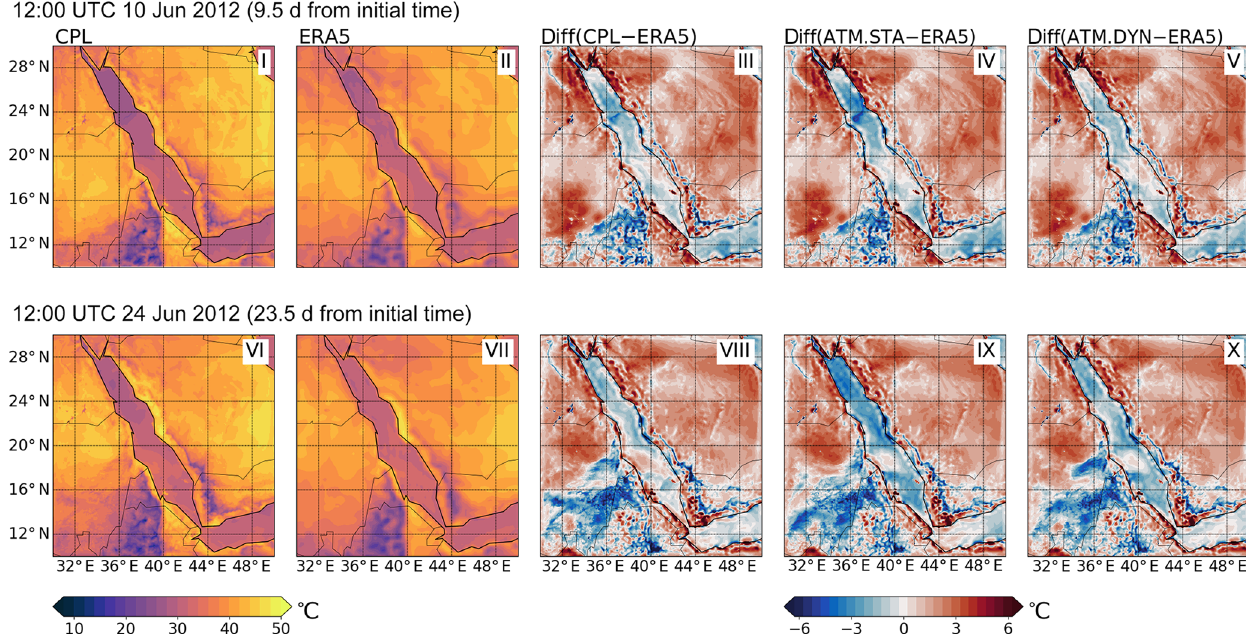
Figure 5. The T 2 obtained in CPL, the T 2 in ERA5, and their difference (CPL − ERA5). The difference between ATM.STA and ATM.DYN with ERA5 data (i.e., ATM.STA − ERA5, ATM.DYN − ERA5) are also presented. The simulation initial time is 00:00UTC 1 June 2012 for both snapshots. Two snapshots are selected: (1) 12:00UTC 10 June 2012 (9.5d from initial time) and (2) 12:00UTC 24 June 2012 (23.5d from initial